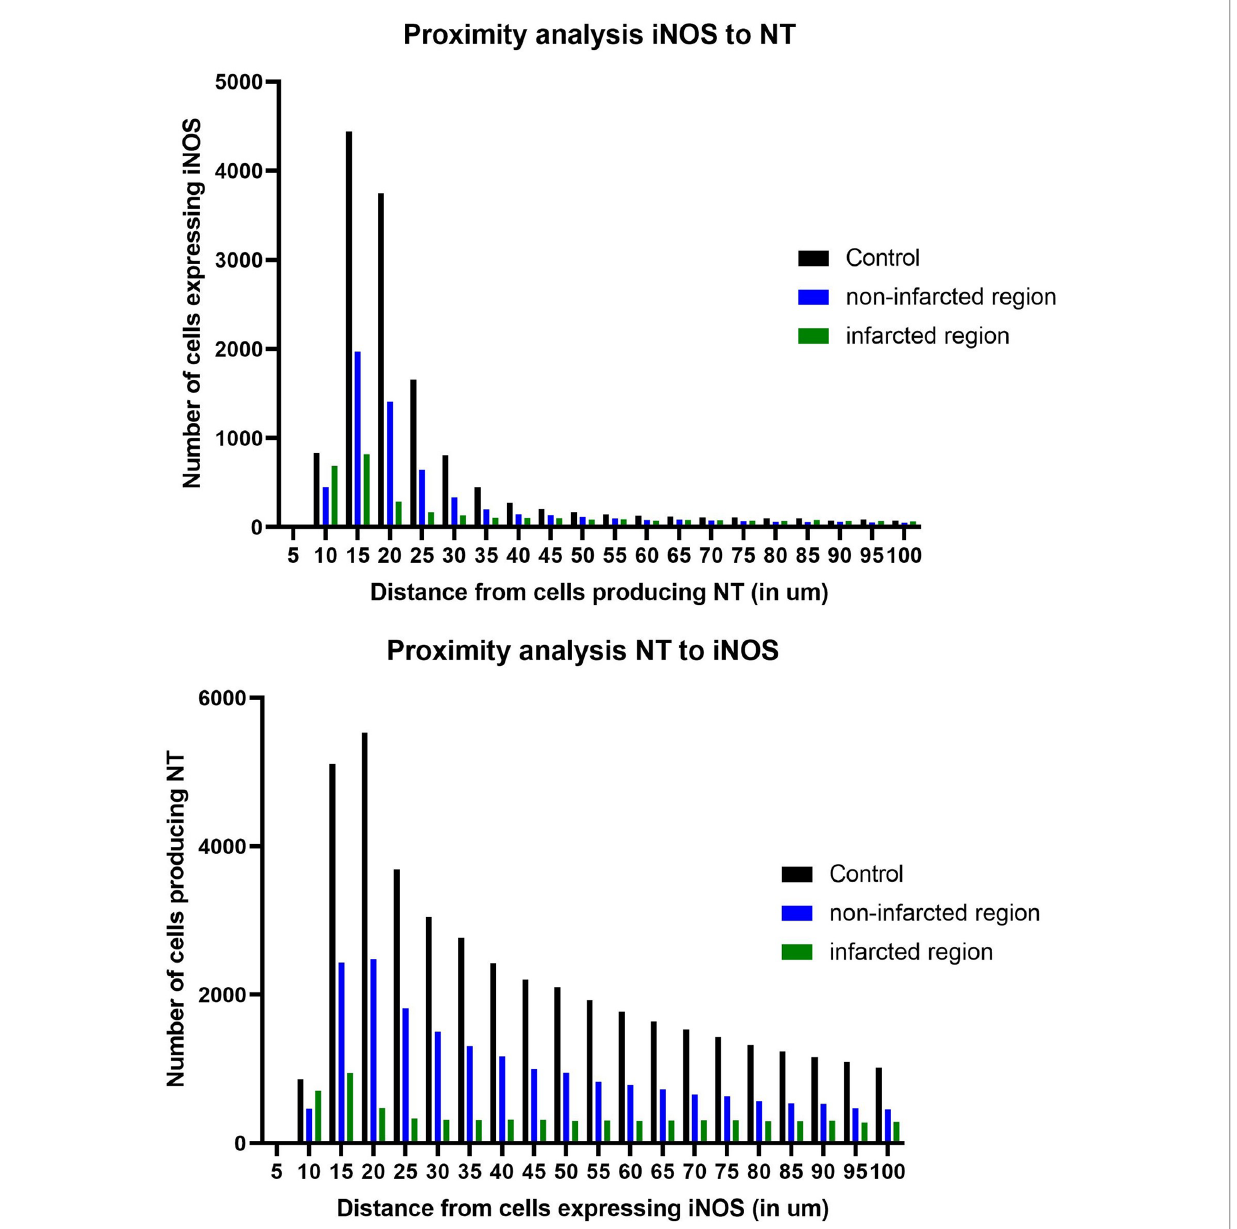
FIGURE 5 Distance between iNOS+ and nitrotyrosine+ (NT+) cells in controls, non-infarcted and infarcted regions. ( A ) Number of iNOS+ and NT+ cells within 100 µm in non-infarcted regions of MI hearts. ( B ) Number of NT+ and iNOS+ cells within 100 µm in infarcted regions of MI hearts. NT+ cells peak within a distance of 10 – 15 µm of